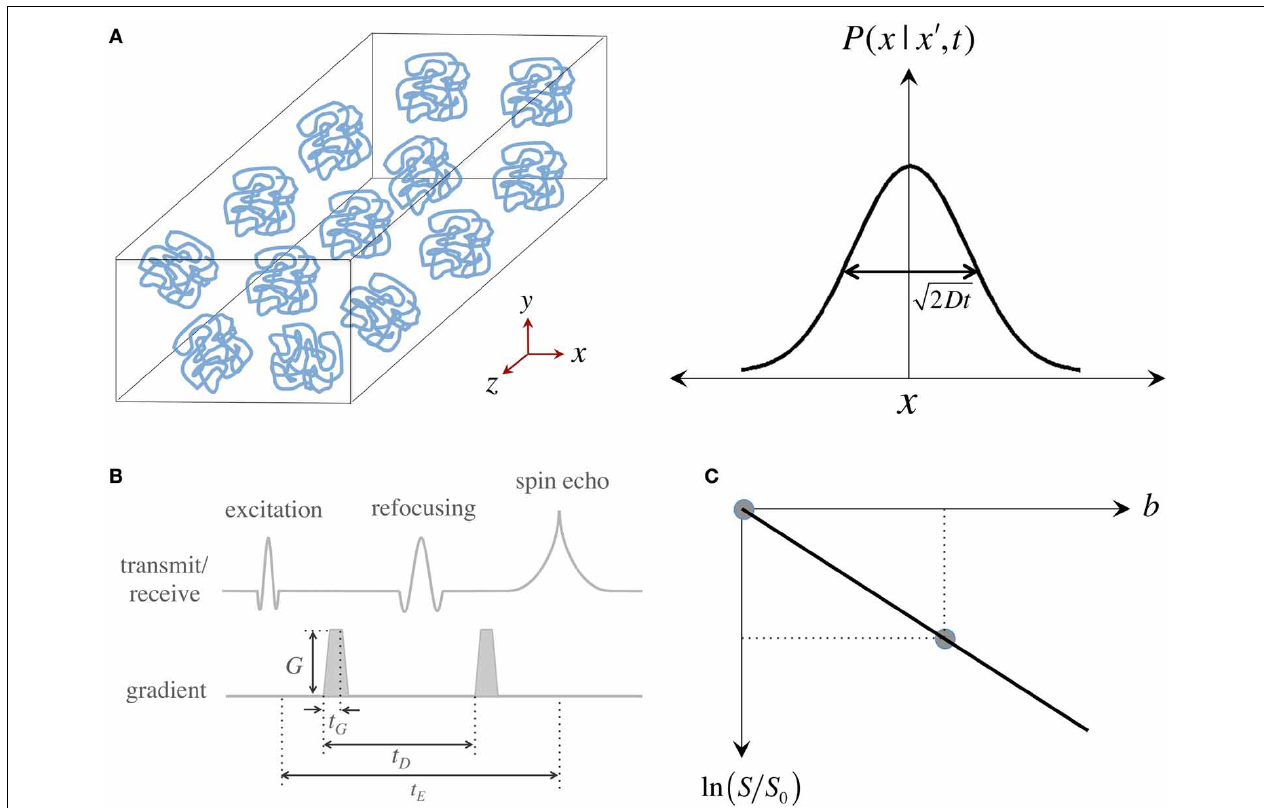
FIGURE 1 | Measurement of the “self-diffusion” coefficient with magnetic resonance. (A) Self-diffusion is a special case of diffusion that describes the relentless motion of microscopic particles in a substance. Such motion is random—it can be described by a “Gaussian” distribution whose width determines how far particles travel on average after some time; the important thing to remember is that only time, the “diffusion time,” and the “self-diffusion coefficient,” D , modulate this width. (B) Illustration of a magnetic resonance pulse sequence that is sensitive to self-diffusion: (i) an “excitation pulse” gives some energy to water protons; (ii) then the first “gradient” encodes where they are; (iii) and some (diffusion) time later, a